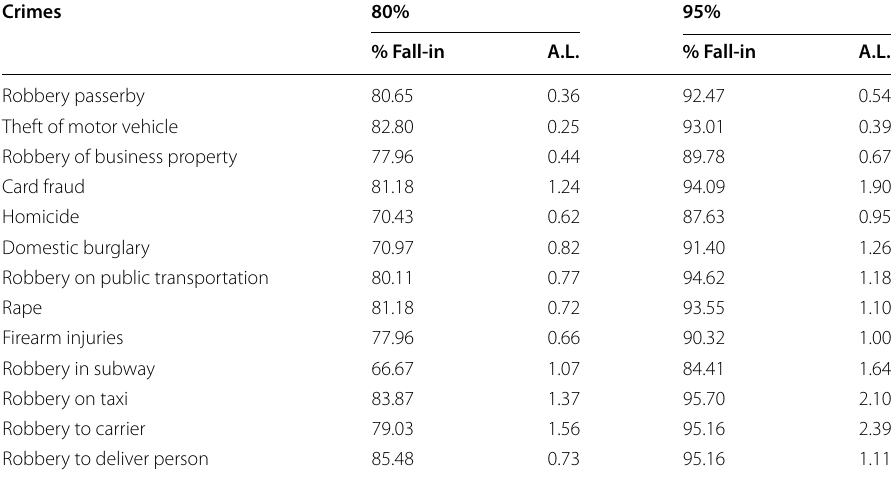
Table 2 Percentage of fall-in for 80% and 95% predictive intervals and their average length